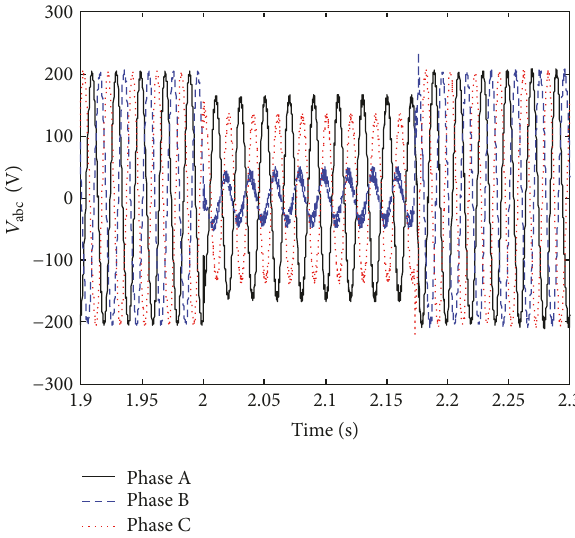
Figure 17: Three-phase voltage characteristics of the wind genera- tion system under the asymmetrical